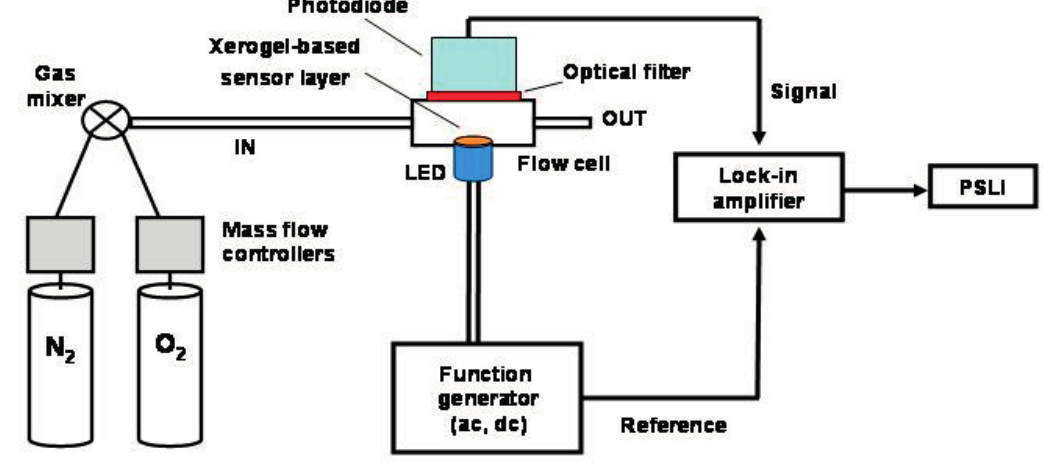
Figure 3. Simplified schematic of the phase-sensitive instrument used in this research. The modulation frequency ( f ) is controlled by the function generator, the detector phase angle ( θ D ) is adjusted with the lock-in amplifier, and the sample composition that reaches the sensor element is controlled by the mass flow